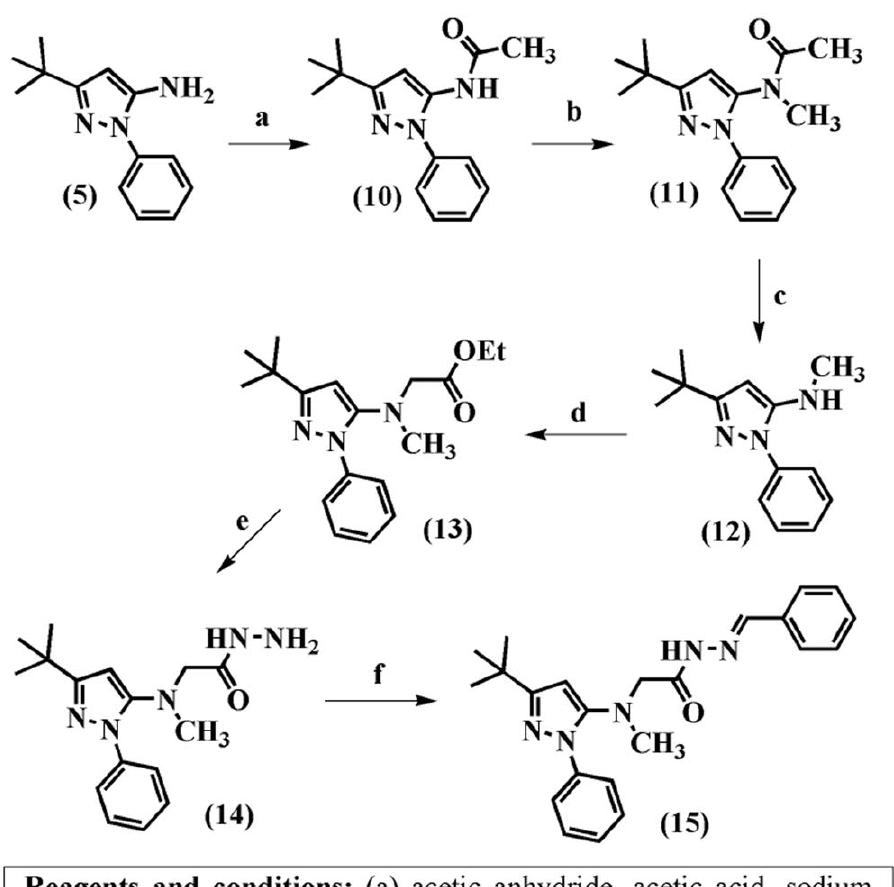
Figure 6. Synthesis of compound 15.